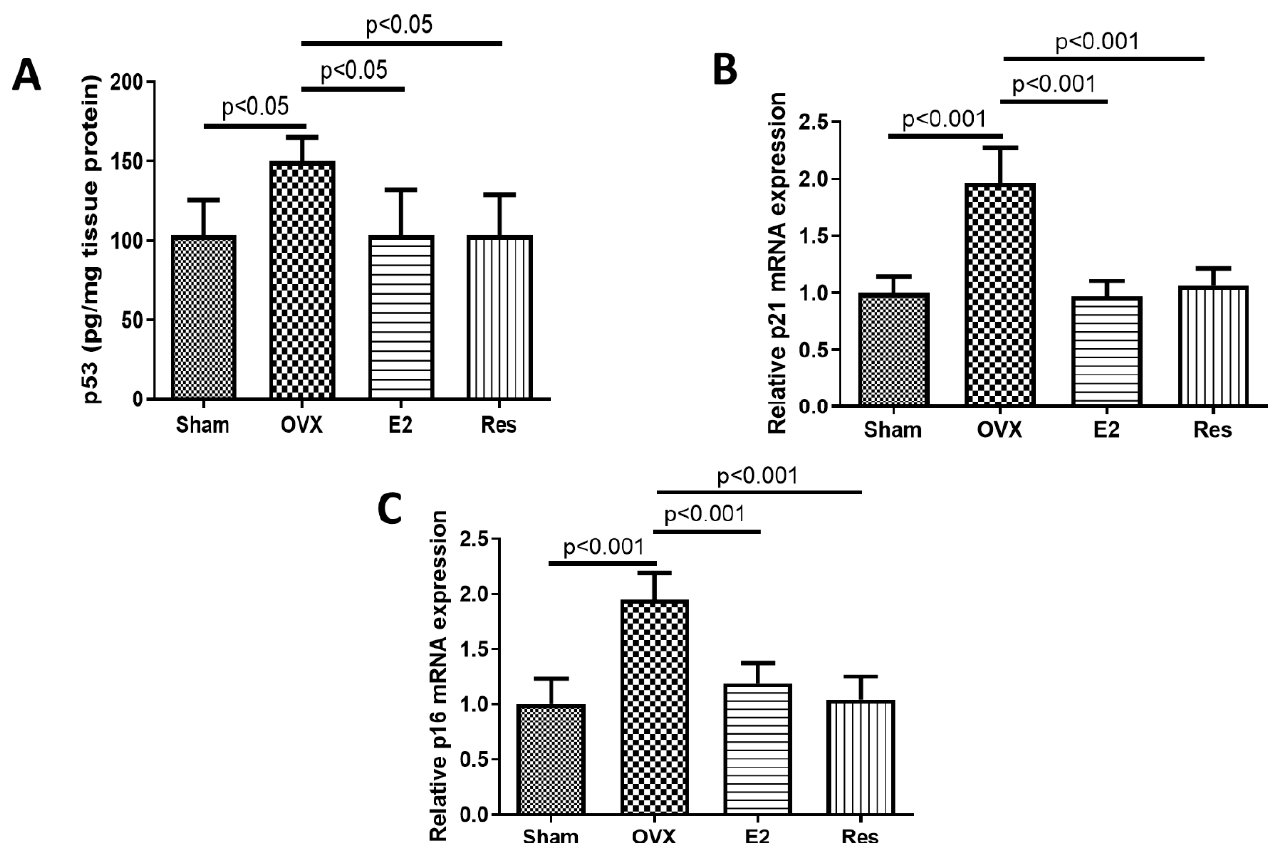
Figure 4. Resveratrol and E2 downregulated the expression of the senescence markers p53, p21 and p16 in the aortas of OVX rats. ( A ) p53 protein level in aorta. ( B ) Relative p21 mRNA expression in aorta. ( C ) Relative p16 mRNA expression in aorta. p53 protein levels were quantified using ELISA. p21 and p16 mRNA expression levels were quantified using RT-PCR. OVX: ovariectomized rats; E2: estradiol; Res: resveratrol. Graphs show mean ± SD, n = 6 each.